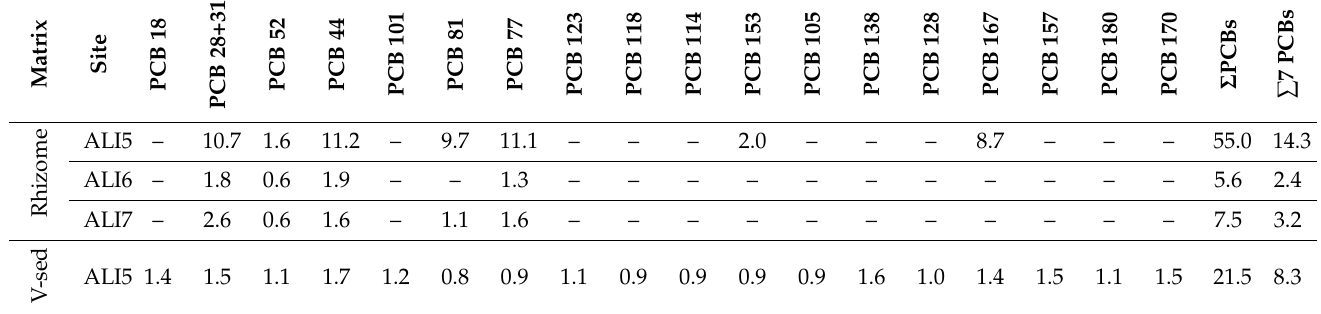
Table 2. Occurrence of PCBs ( µ g kg − 1 d.w.) in the rhizomes of the marine plant P. oceanica and vegetated sediments (V-sed). Note that only the sampling areas where contamination was detected have been included in the table.